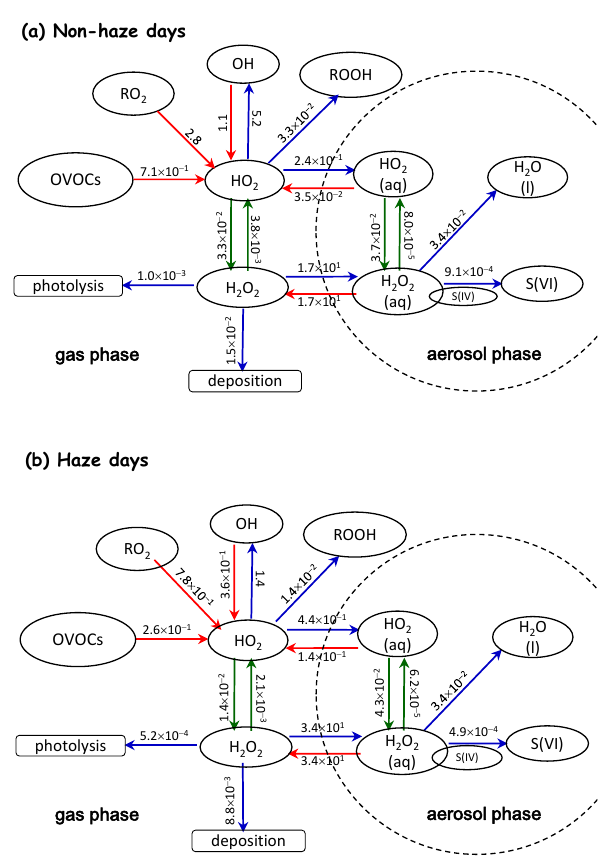
Fig. 9. 24h average OH and HO 2 budget on (a) non-haze days and (b) haze days. Red arrows refer to the sources of HO 2 , blue arrows refer to the sinks of HO 2 and H 2 O 2 , and green arrows refer to the conversion between HO 2 and H 2 O 2 . All rates are in ppbvh − 1 . The rates for aqueous phase reactions are converted to ppbvh − 1 accord- ing to the number of molecules per unit volume. HO 2 (aq) refers to the sum of aqueous phase HO 2 and O − . The average aerosol liquid 2 water content is ∼ 34µgm − 3 for non-haze days and ∼ 71µgm − 3 for haze